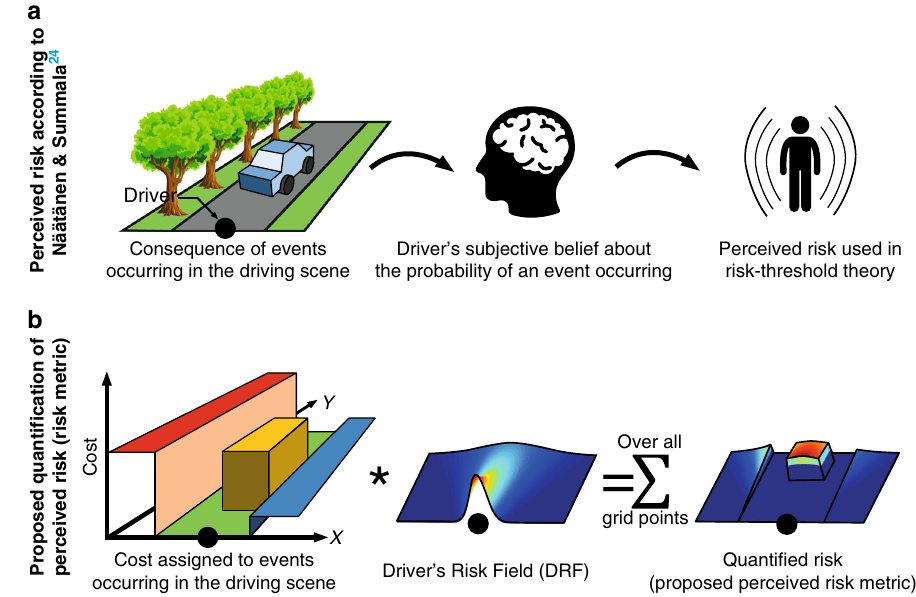
* Fig. 1 Visualising the quanti fi cation of driver ’ s perceived risk. a This row illustrates Näätänen and Summala ’ s 24 formulation of perceived risk. The consequence of an event (e.g., colliding with a tree) and the driver ’ s subjective belief about the probability of that event occurring, form the driver ’ s perceived risk. The driver in the ego car is indicated using the black marker. b This row illustrates the proposed quanti fi cation of this perceived risk. The cost of each element in the driving scene is multiplied with the Driver ’ s Risk Field (DRF) that represents the driver ’ s belief of the probability of being in a position. This product summed over all grid points generates the estimate of quanti fi ed